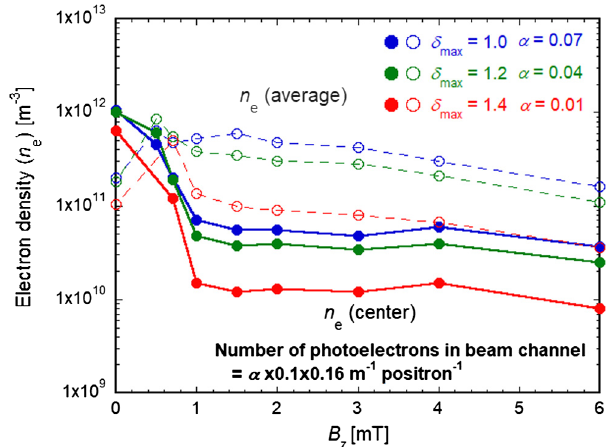
FIG. 10. Measured electron density ( n e ) at the center and the average of a beam channel in type-1 units as a function of the magnetic field in the beam direction ( B z ) for several maximum SEY ( δ ) and α (see Sec. max